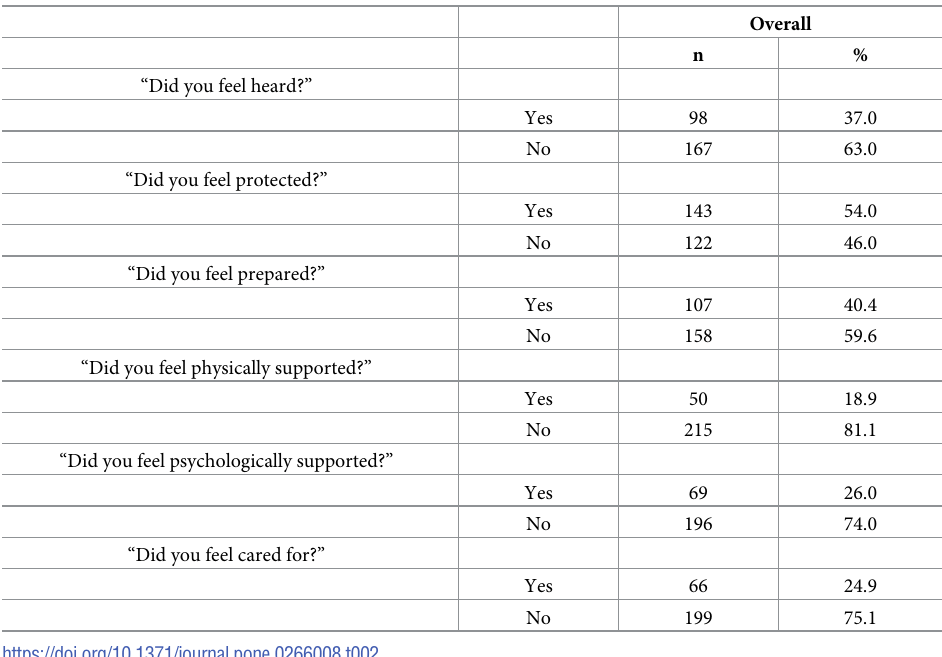
Table 2. Perceptions of